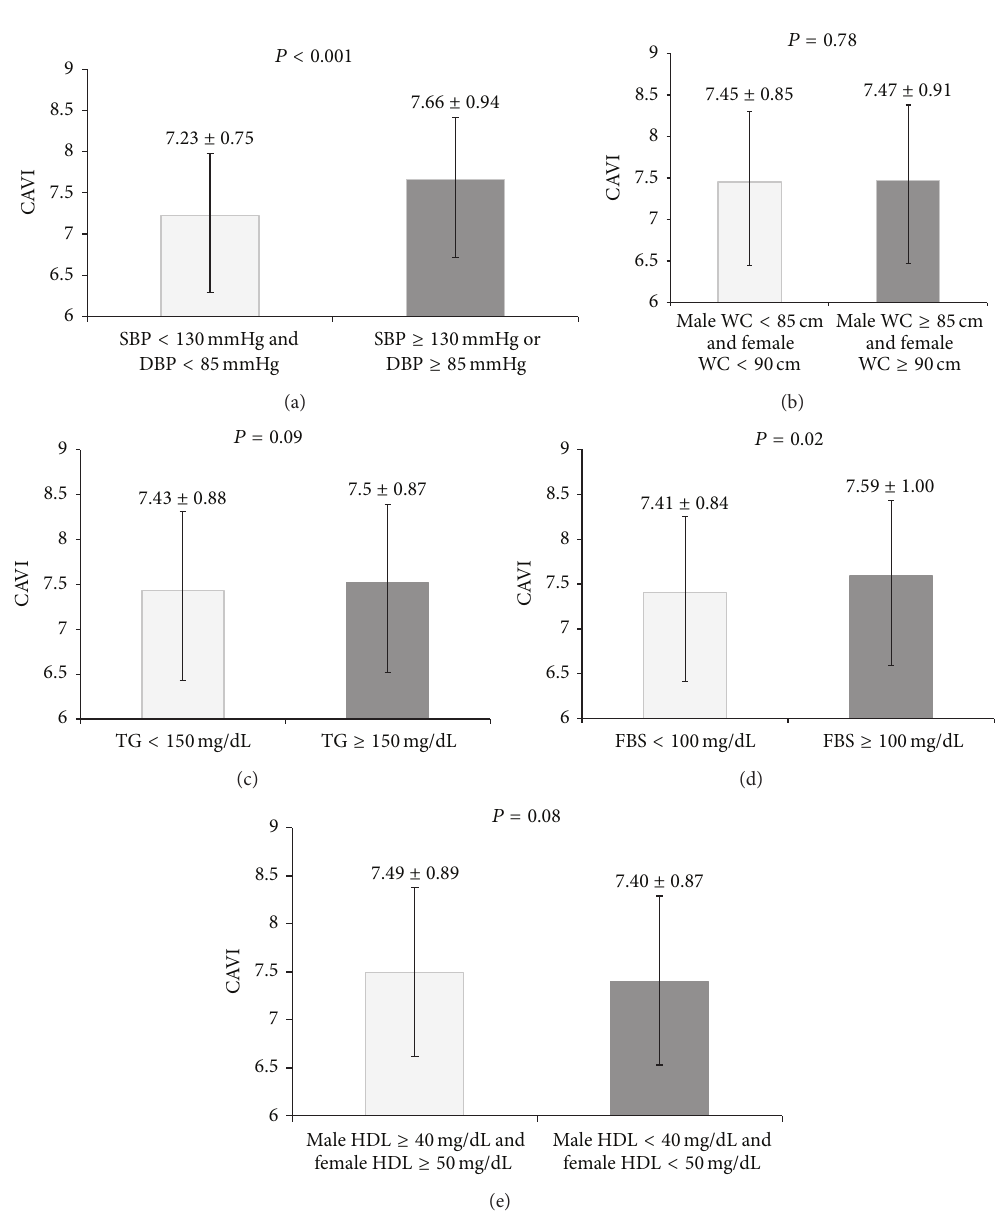
Figure 2: The relation between cardioankle vascular index (CAVI) and the component of metabolic syndrome. 𝑃 values were calculated by ANCOVA and age-adjusted